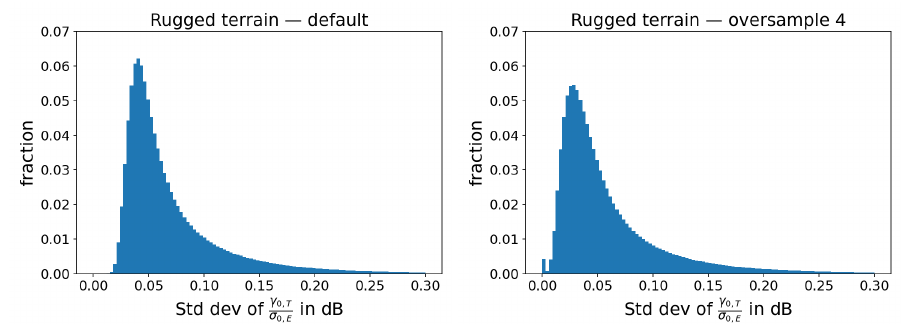
Figure 8. Histogram of the standard deviation of γ 0, T / σ 0, E for all pixels in a rugged terrain burst over Big Bear, California with default oversampling factor ( Left ) and an oversampling factor multiple of 4 ( Right ). Data were masked with the shadow–layover mask before the histograms were estimated, but the long tail of the histogram for the rugged terrain burst indicates that there could be other subtle processing effects to account for in steep